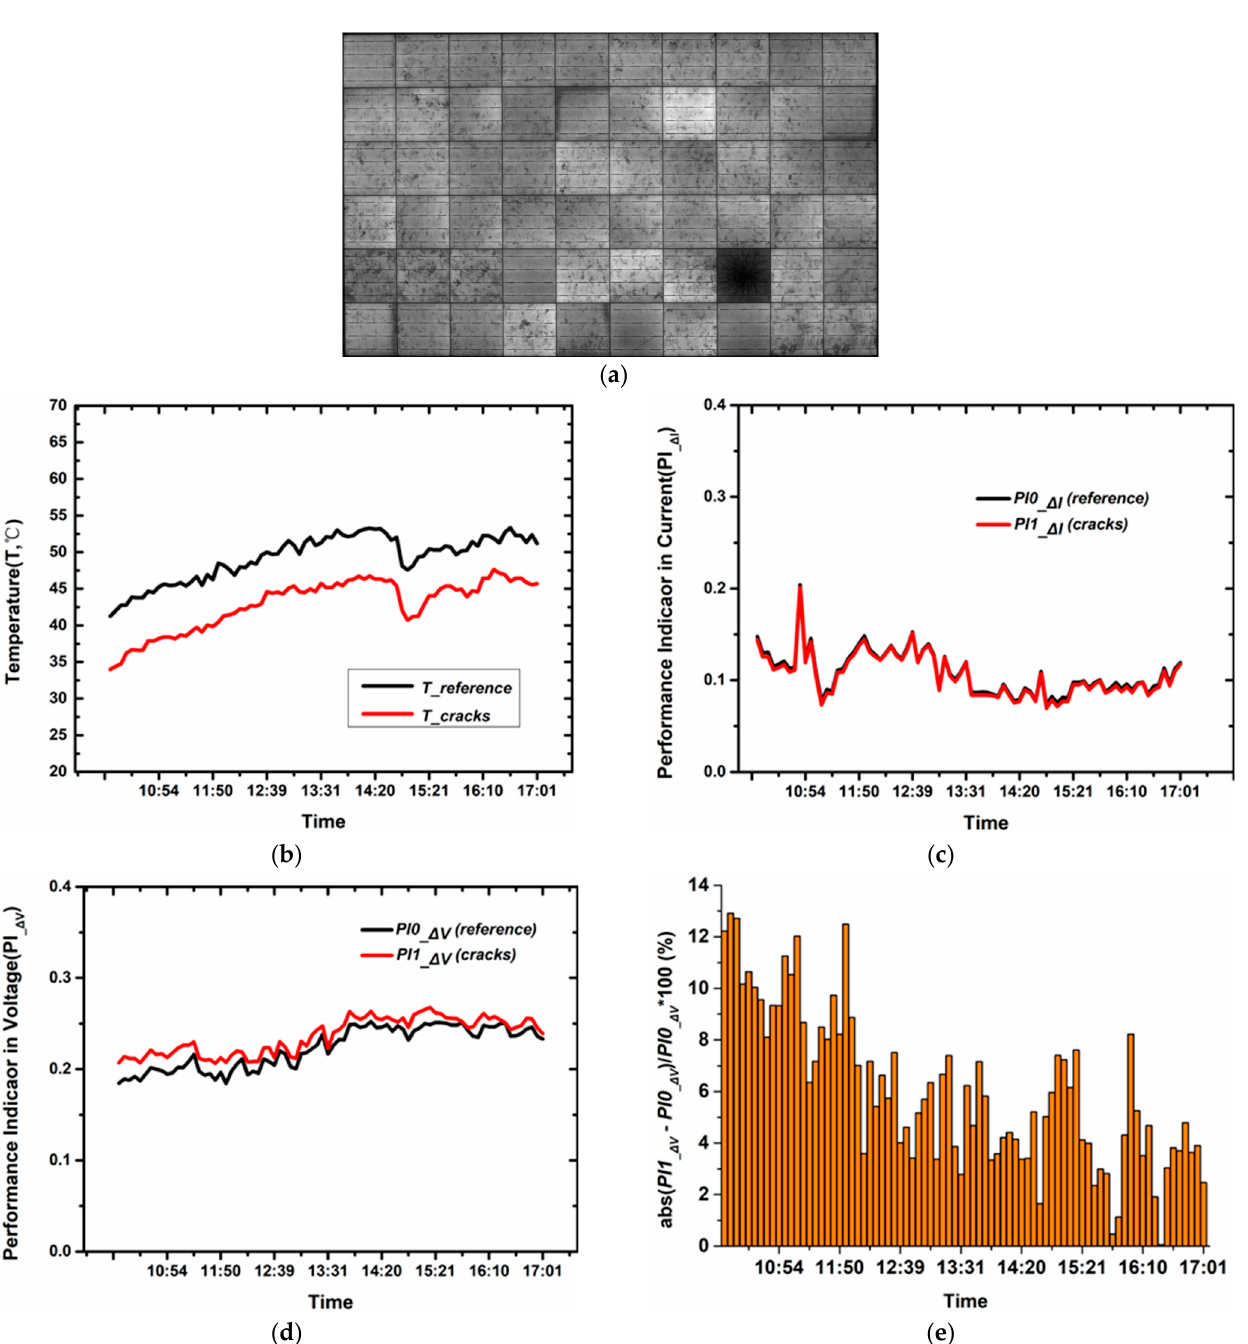
Figure 13. Performance indicators of cracks: ( a ) cracks in EL image; ( b ) temperature for cracked and reference modules; ( c ) performance indicator in current; ( d ) performance indicator in voltage; ( e ) the percentage deviation of PI _ Δ V from the reference value.